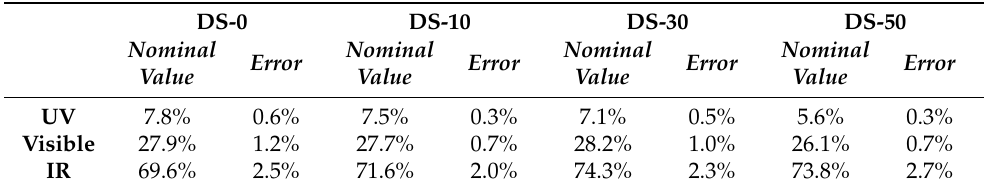
Table 8. Mean spectral reflectance calculated for each wavelength interval, for each brick specimen.